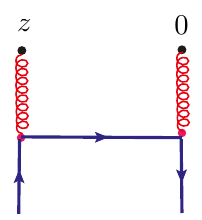
Figure 5 . Gluon-quark mixing